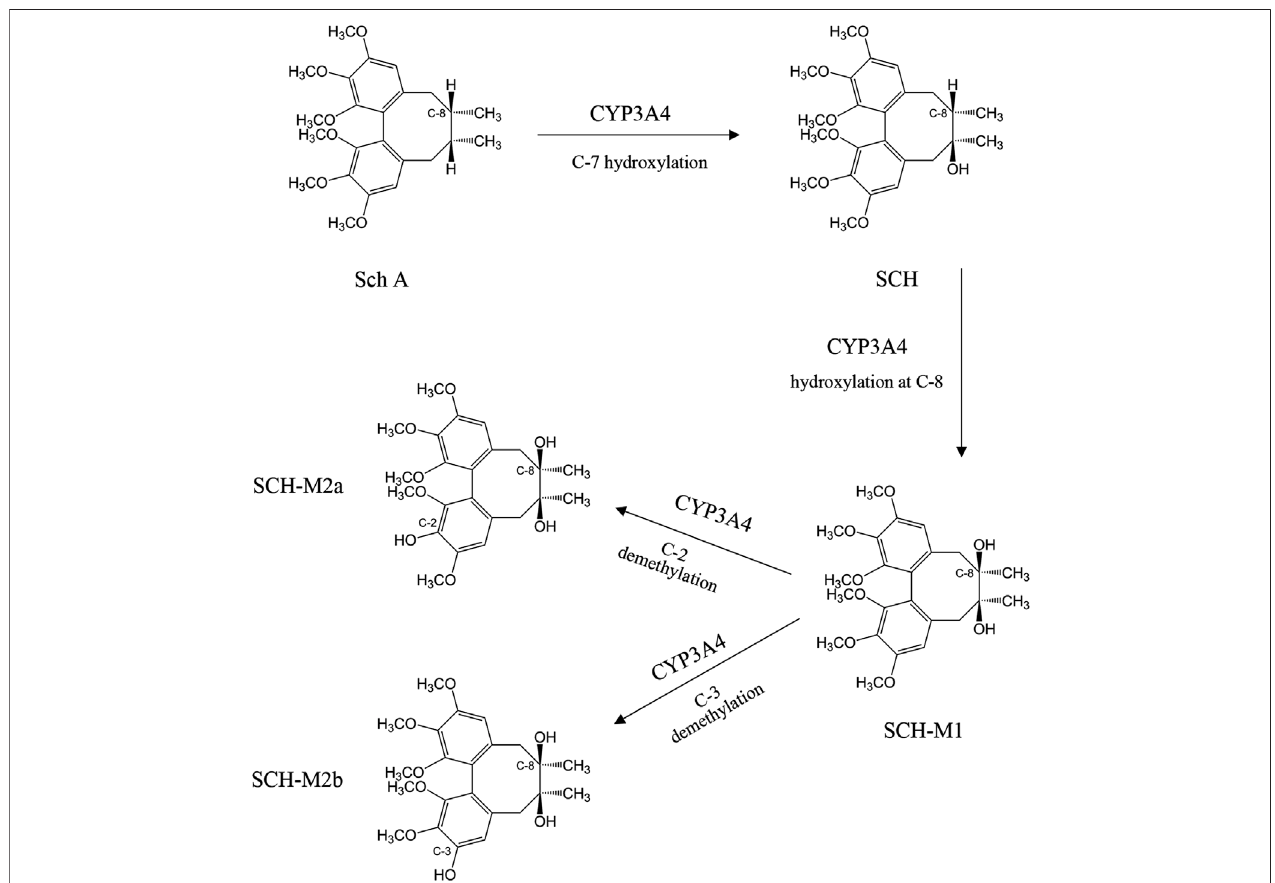
FIGURE 2 | The metabolism of schisandrin A (Sch A) and schisandrin (SCH).